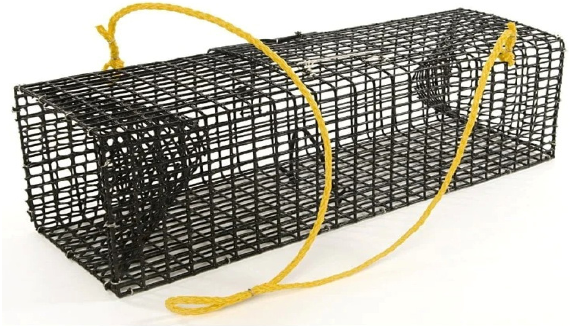
Figure 1. Crayfish